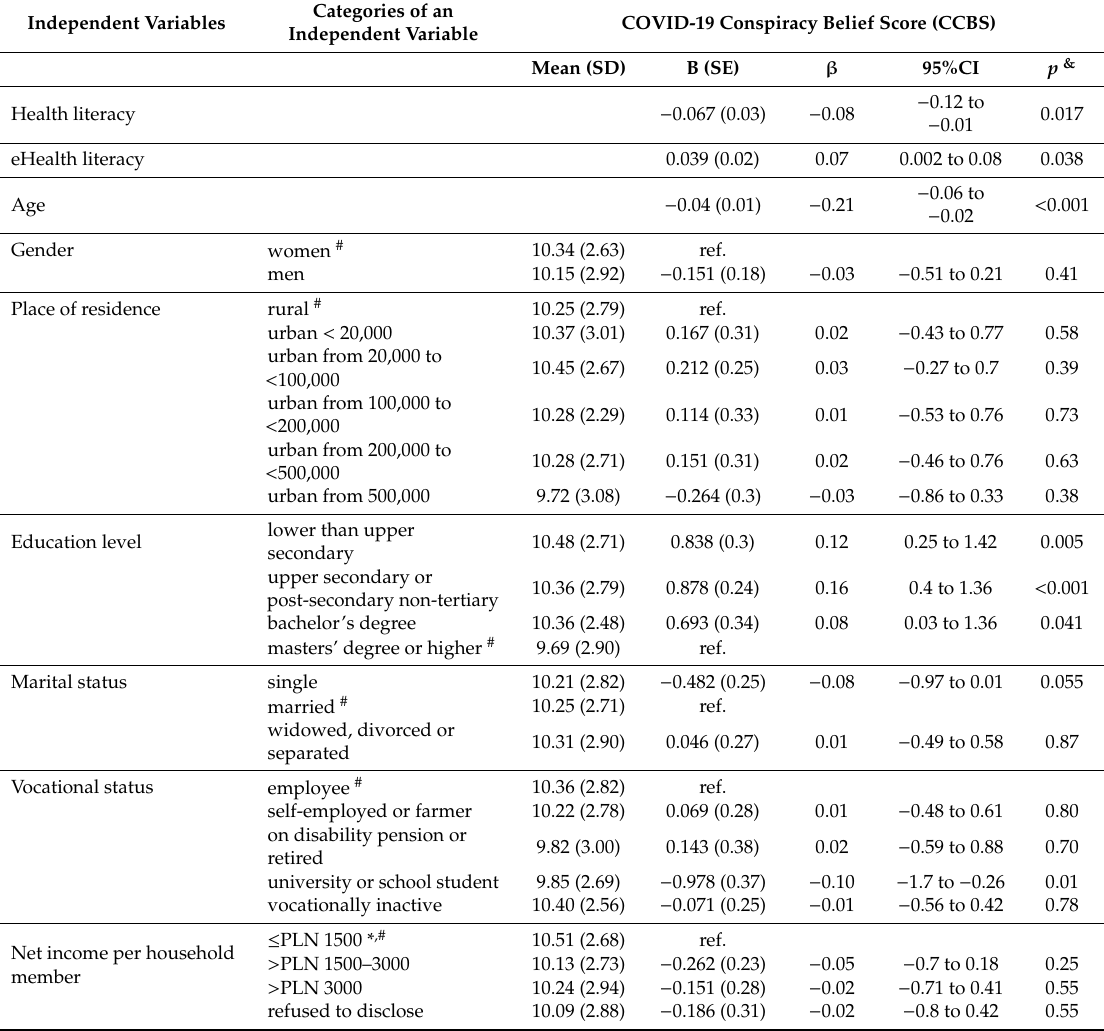
Table 2. Multivariate linear regression model for predictors of the COVID-19 Conspiracy Belief Score. Independent